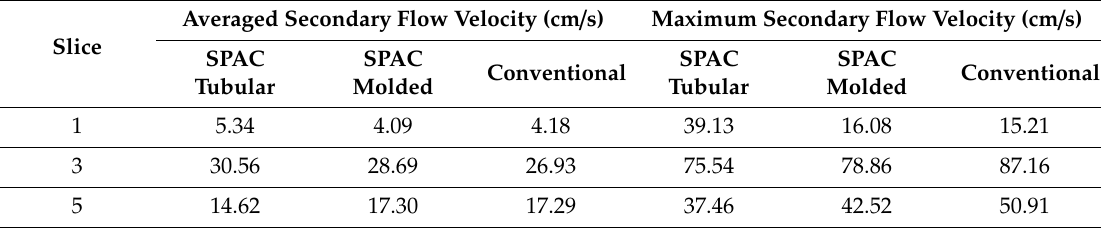
Table 5. The maximum and averaged secondary flow velocity of all designs at t 4 .